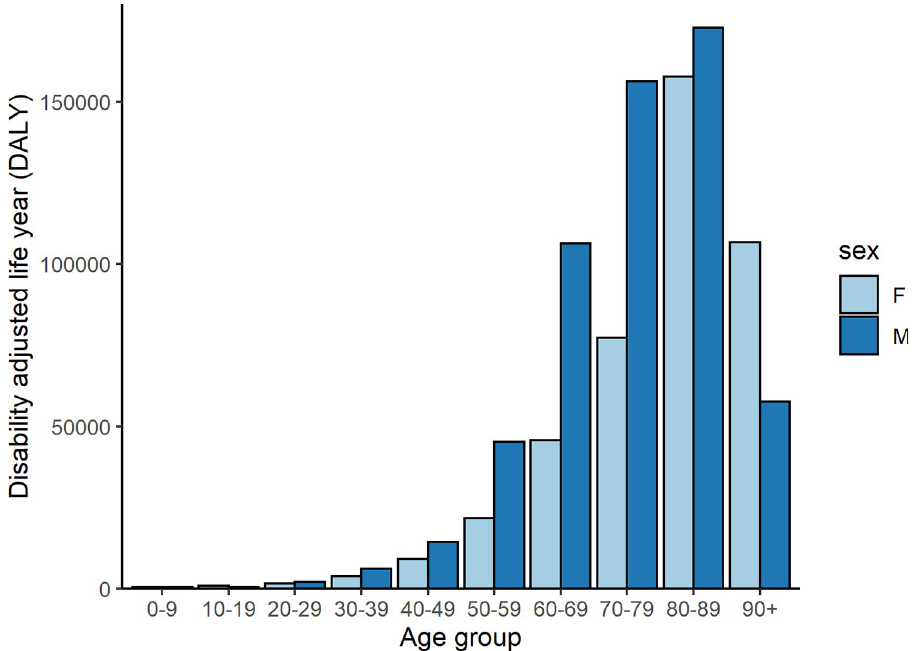
Fig 4. Disability adjusted life years due to acute symptomatic COVID-19 infections in France in 2020 by age and sex.